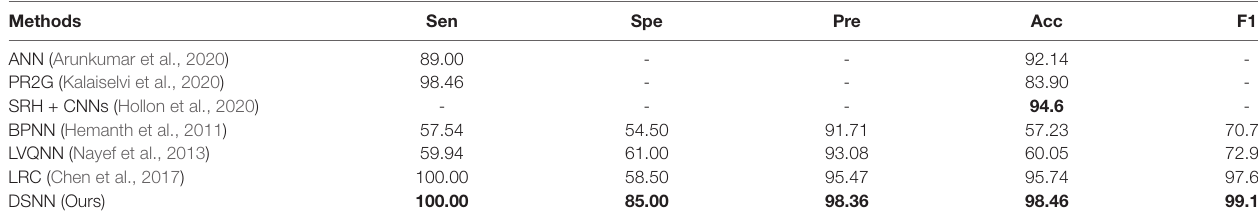
TABLE 8 | Comparison with other state-of-the-art methods (unit: